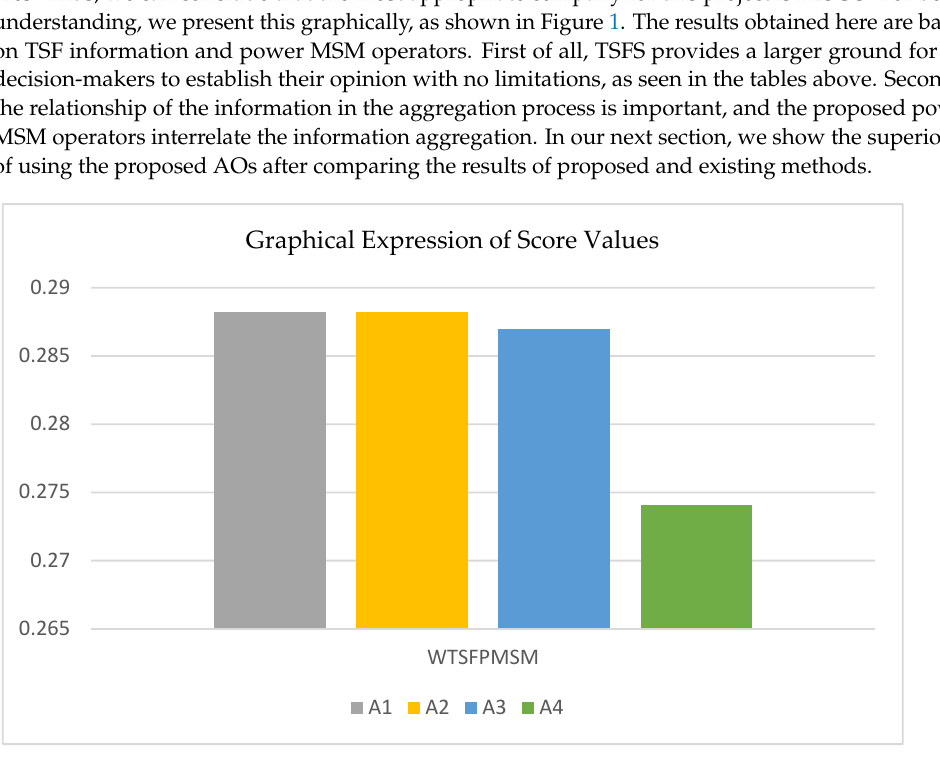
Figure 1. Illustration of the information in Table 6 .